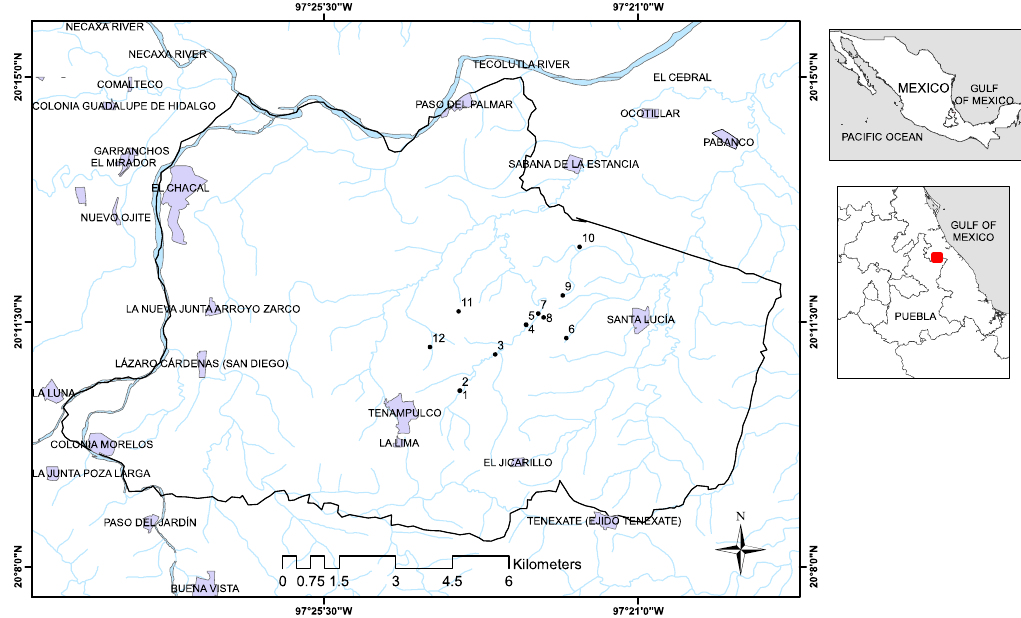
Figure 2. Geolocation of Tenampulco and sampling sites. Table 1. Coordinates and type of water collected at the different sampling points.